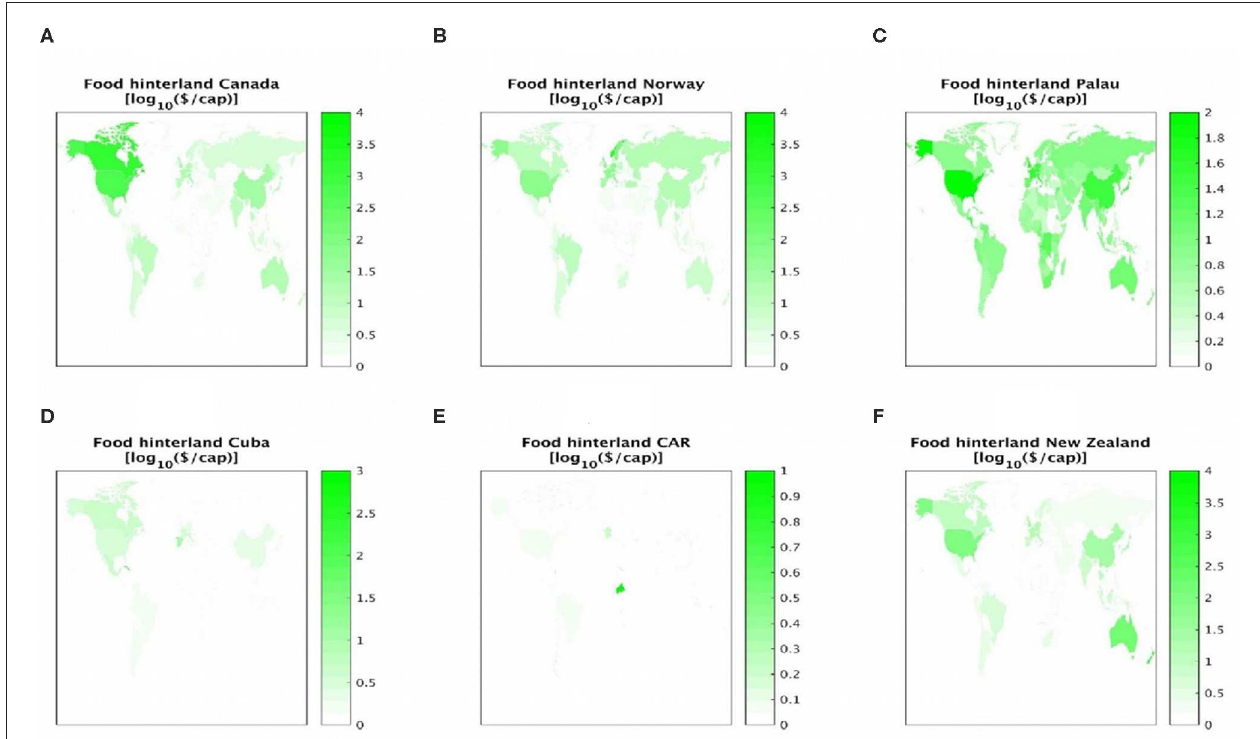
FIGURE 3 | Global food hinterlands of countries with low populations. Global food hinterlands of Canada (A) , Norway (B) , Palau (C) , Cuba (D) , the Central African Republic (CAR) (E) , and New Zealand (F) . To relate the production values to population size in the consuming countries, the maps are color-coded in units of log 10 (US$/cap), so that e.g., 3 = US$1,000/cap.